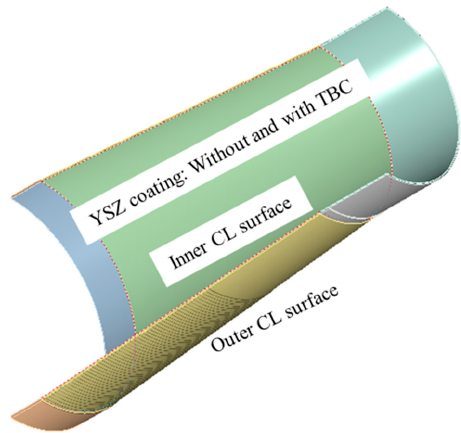
Figure 6. Simulation model of combustor liner only without and with TBC for model-3.